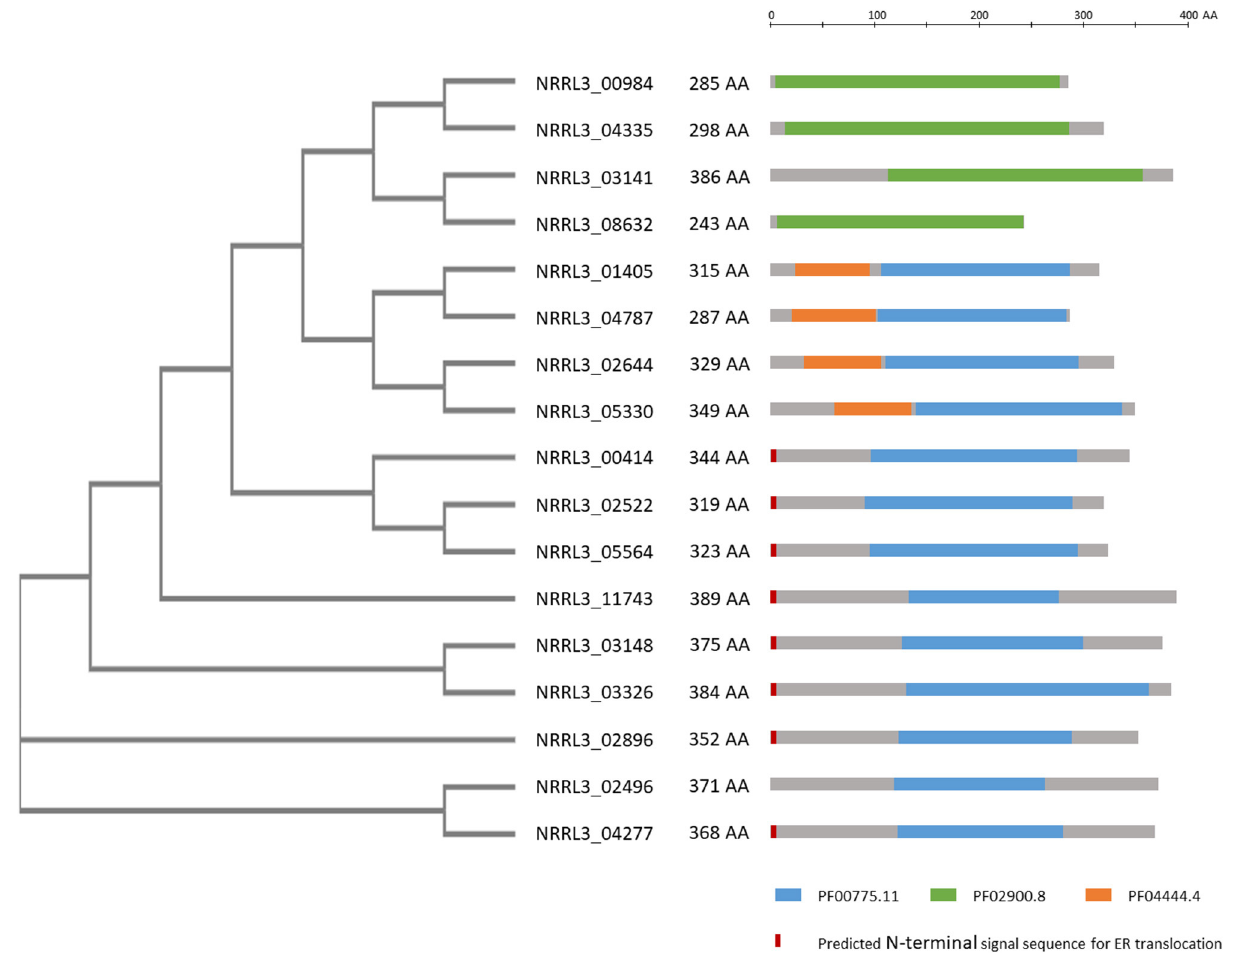
FIGURE 4 | Overview of phylogeny and PFAM domains of 17 ring cleavage enzymes in the genome of A. niger. Phylogenetic relationship of the proteins, their length in amino acids are given. Gray bars indicate the enzymes with the colored bars indicating PFAM domains present on the enzyme. PFAM domains include: Blue: PF00775.11: dioxygenase, Green: PF02900.8: catalytic LigB subunit of aromatic ring-opening dioxygenase, Orange: PF04444.4: catechol dioxygenase N-terminus. In red/orange the presence of a predicted signal sequence is given. PFAM predictions were taken from